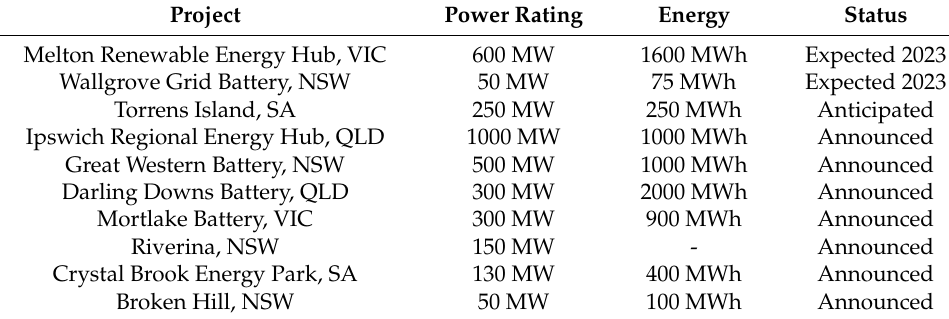
Table 6. Announced battery energy storage systems in Australia [11].